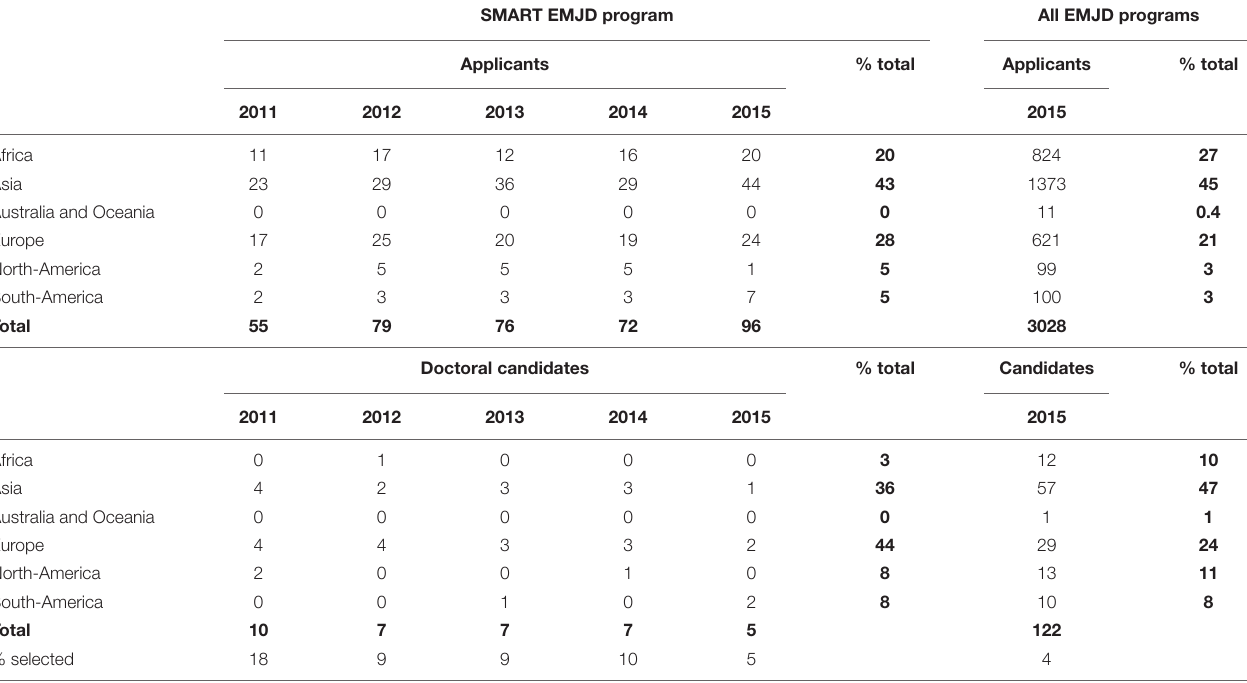
TABLE 2 | Number of applicants (top panel, n = 378) and doctoral candidates (bottom panel; n = 36) per year and continent for the SMART EMJD and total applicants and doctoral candidates in all EMJDs (including SMART) in 2015. SMART EMJD program All EMJD